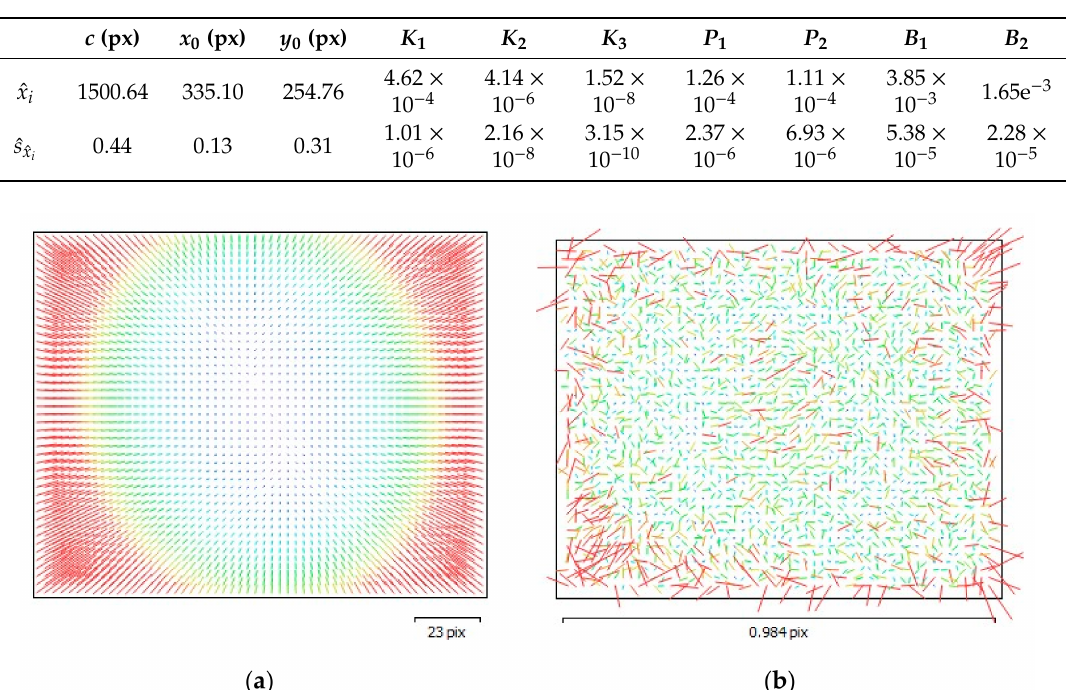
Figure 2. Average re-projection error in pixels ( a ) without the distortion model and ( b ) with the adopted distortion